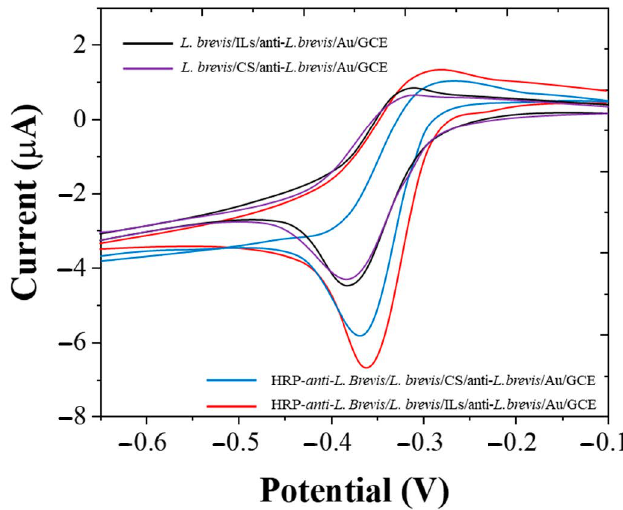
Figure 3. CVs of L. brevis /ILs/anti- L. brevis /Au/GCE, L. brevis /CS/anti- L. brevis /Au/GCE, HRP-anti- L. brevis/L. brevis /ILs/anti- L. brevis /Au/GCE and HRP-anti- L. brevis/L. brevis /CS/anti- L. brevis /Au/GCE.